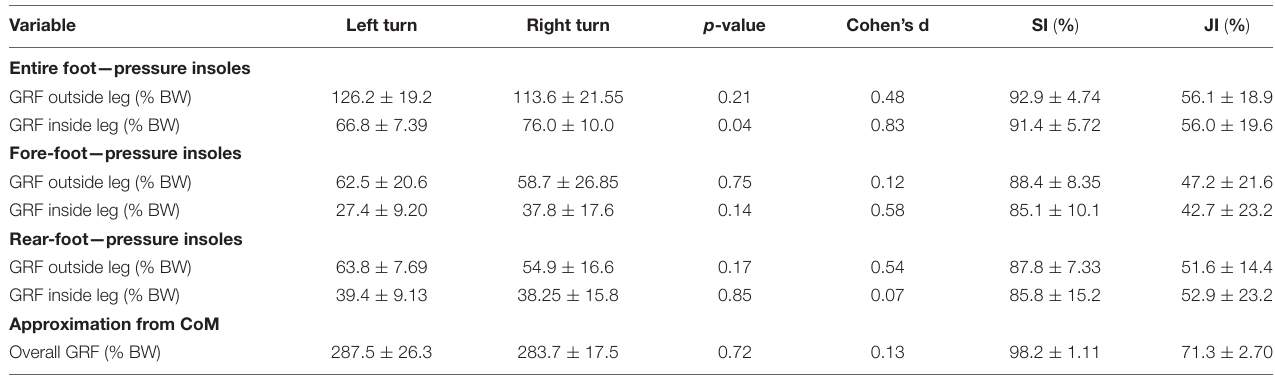
TABLE 2 | The values (means ± standard deviations, statistical comparison of the right and left legs) of the ground reaction forces (GRF) measured and corresponding symmetry and Jaccard indices (dependent